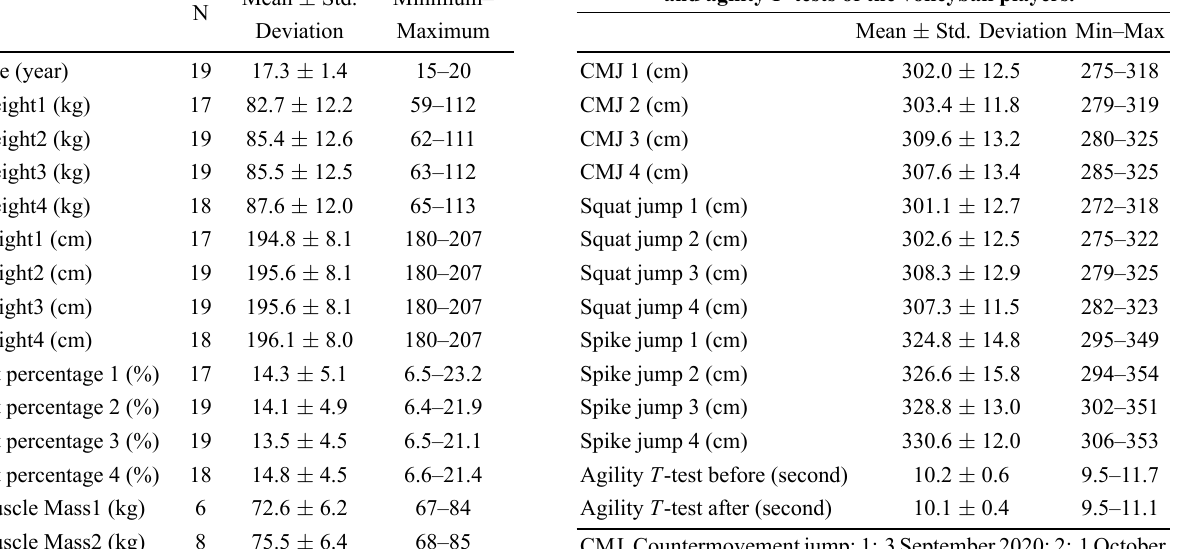
Table 1. Characteristics of the volleyball players.